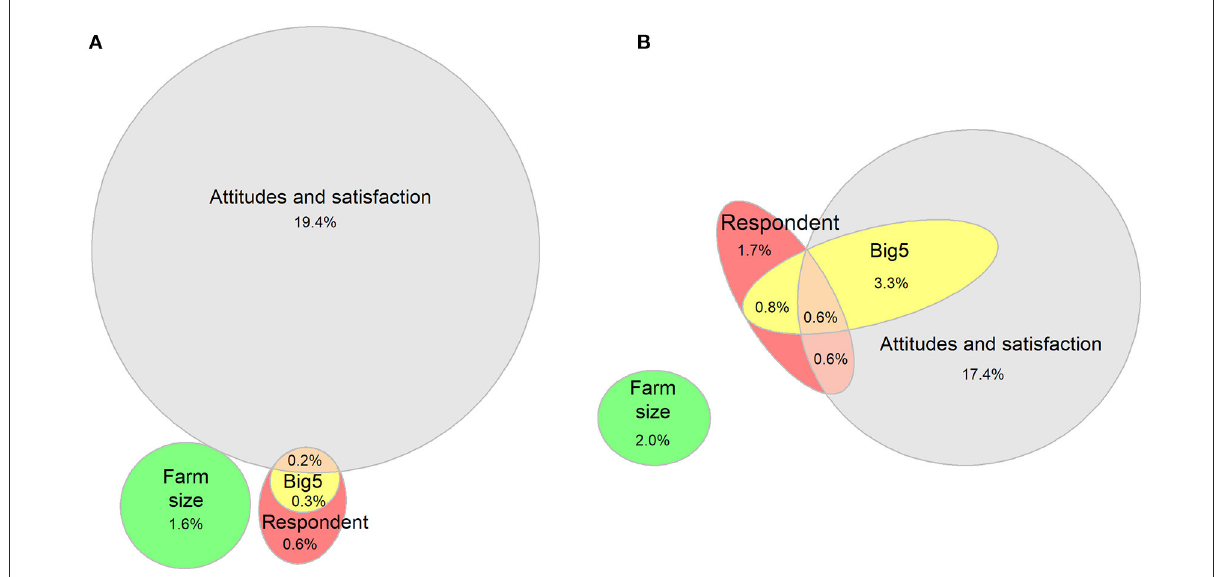
FIGURE5 Euler diagram of the results of variance partitioning analysis for yearly calf mortality risk during the first 21 days (A) and 22–90 days of age (B) . The numerical values and size of the ellipses and their intersections visualize the variance (%) of yearly calf mortality risk described by farm size (number of calves); respondent-specific traits (age, sex, education level, and working experience); selected calf care workers’ attitudes; opinions; and satisfaction (6 and 11 questions with p < 0.25 in correlation analysis with yearly calf mortality risk during the first 21 days of age and 22–90 days of age, respectively) and all Big Five personality domains.